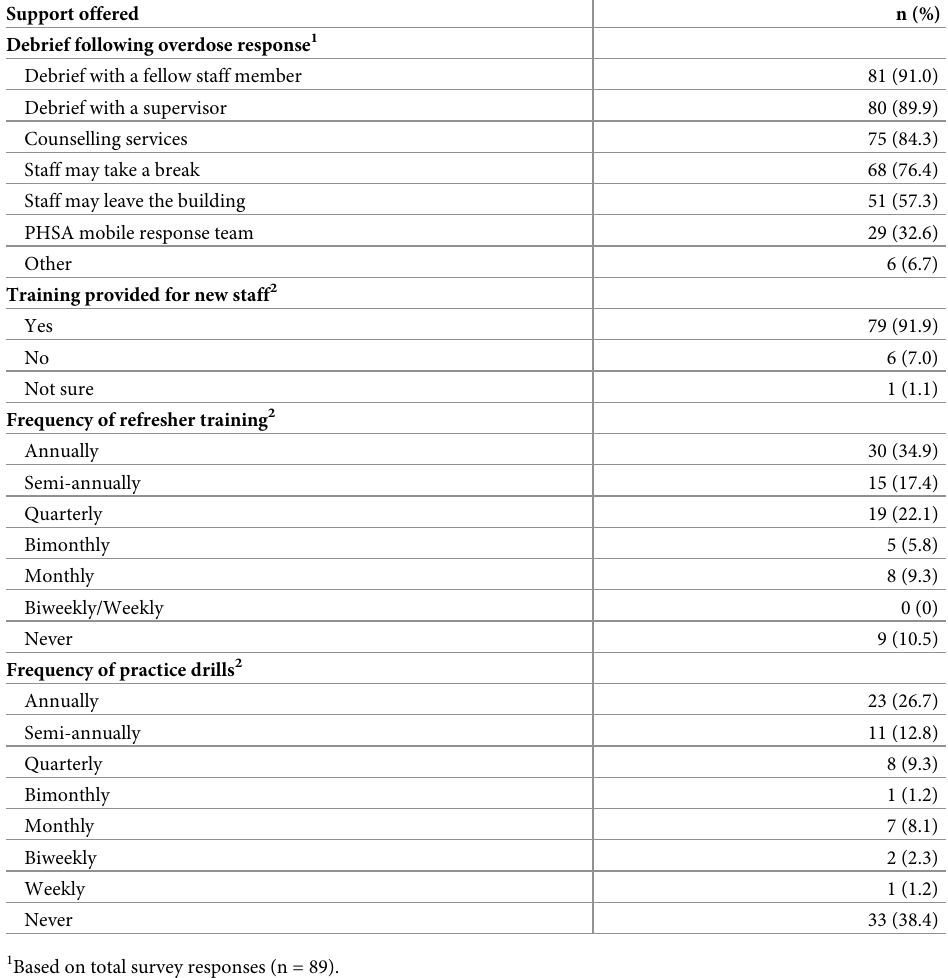
Table 4. Supports offered to staff following an overdose event and ongoing staff training offered based on survey